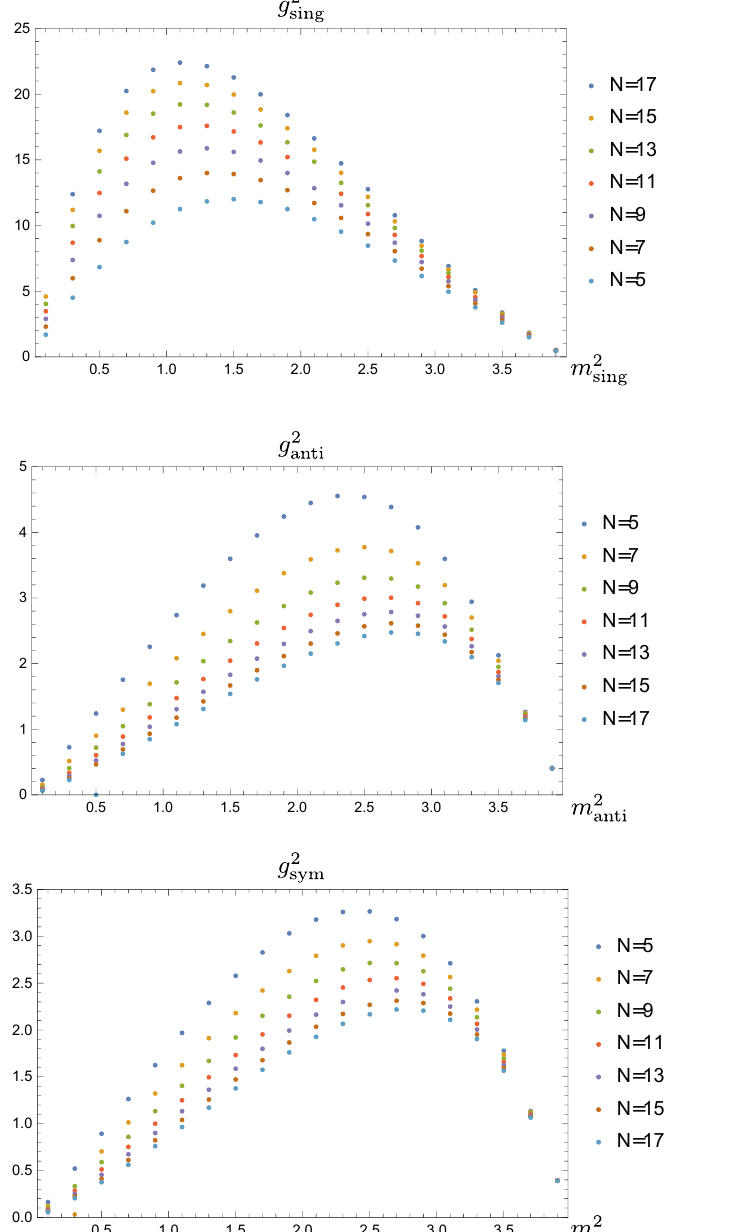
Figure 8 . Maximum couplings obtained numerically for the case of a single bound state in the singlet (top), anti-symmetric (middle) or symmetric (bottom) representation. The three panels correspond to the three possible representations. (The numerics were done with n grid = 70 and various N ’s.)